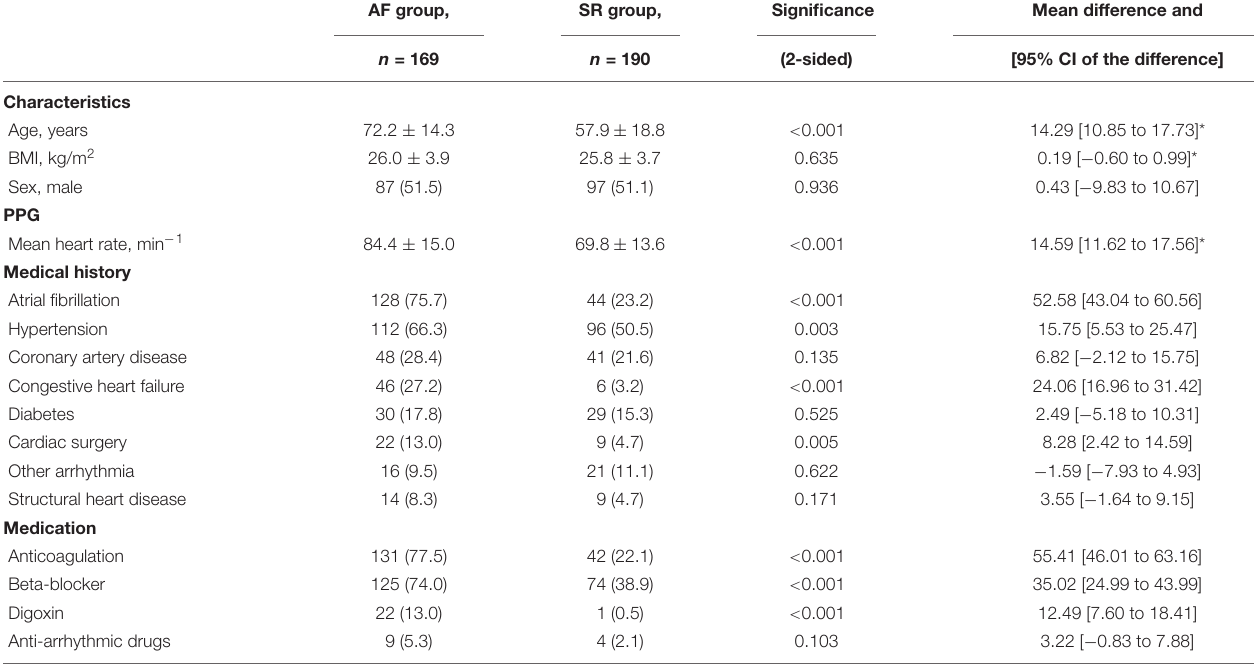
TABLE 1 | Clinical characteristics of the patients.